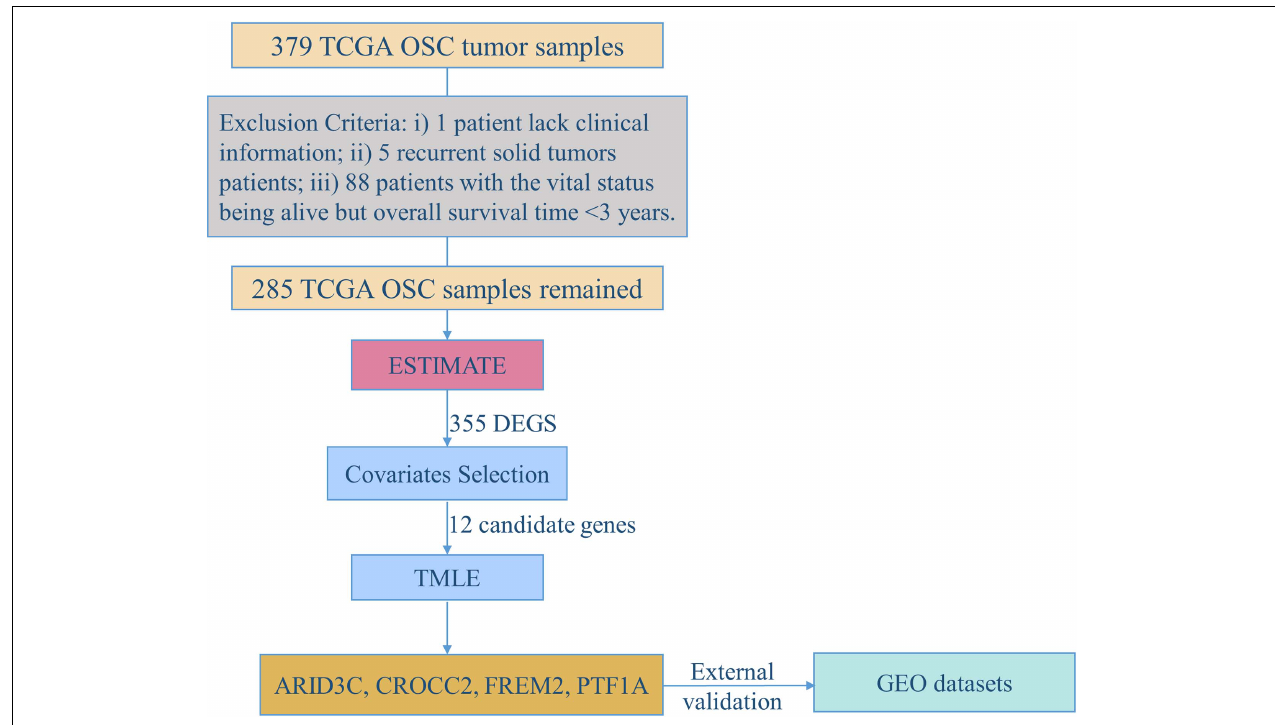
FIGURE 1 | The flowchart for identification of prognostic biomarkers.